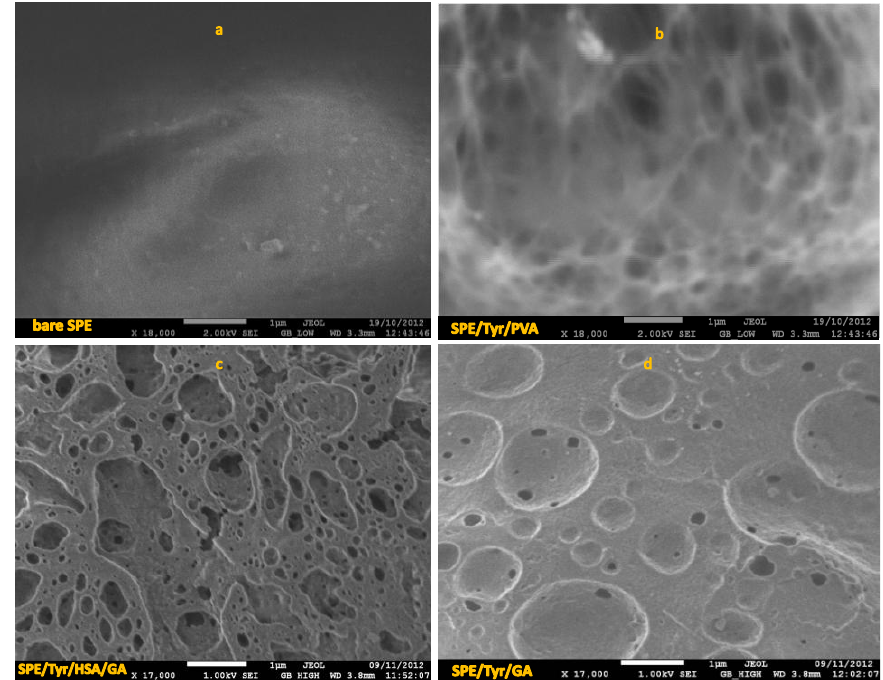
Figure 6. Results of the SEM morphology analysis of the bare SPE ( a ) and tyrosinase immobilized through: ( b ) entrapment, SPE/Tyr/PVA, ( c ) pure cross-linking with HSA, SPE/Tyr/HAS/GA and ( d ) cross-linking at (40.0 ± 0.5) °C,